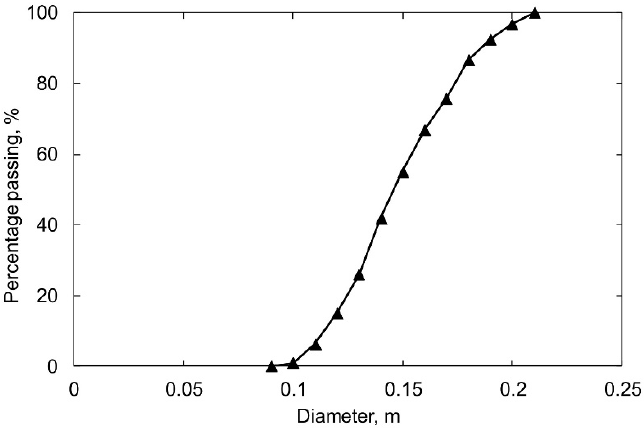
Figure 14. Equivalent sphere-size distribution of test sample (Rieksts et al., 2017 [27]).